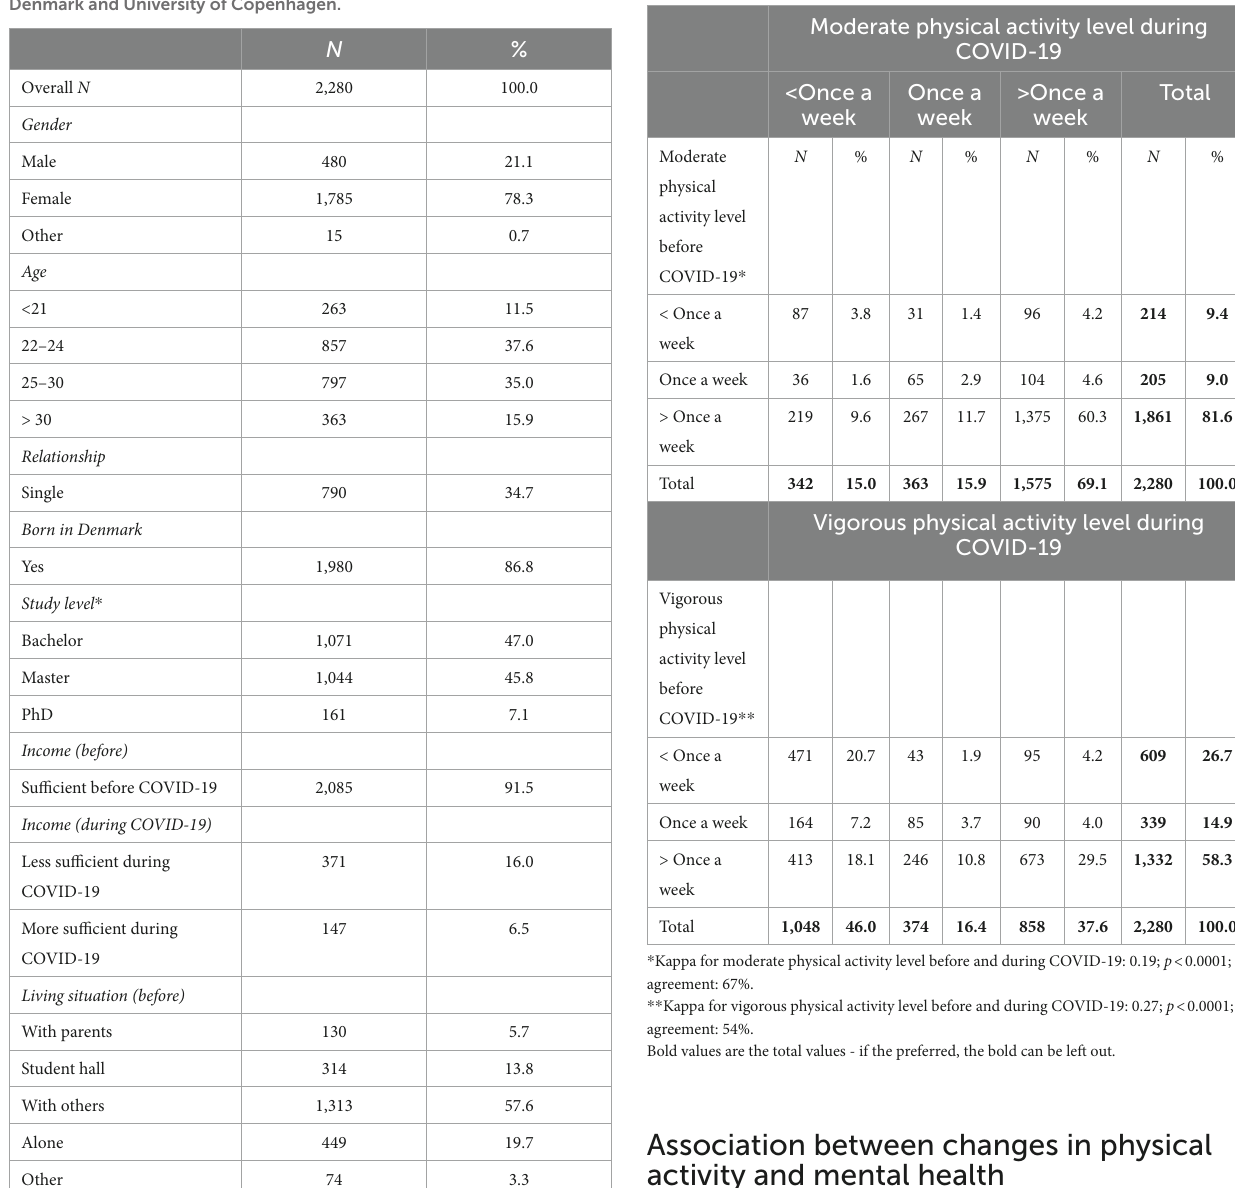
TABLE 2 Changes in University students’ average of performing moderate and vigorous physical activity more than once a week before COVID-19 lockdown and during COVID-19 ( n and cell